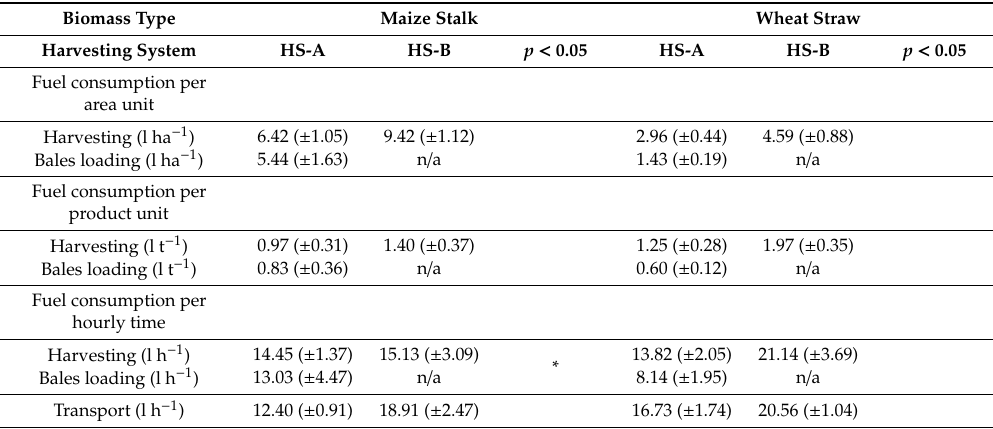
Table 3. Consumption measured during harvesting and transport of maize stalks and wheat